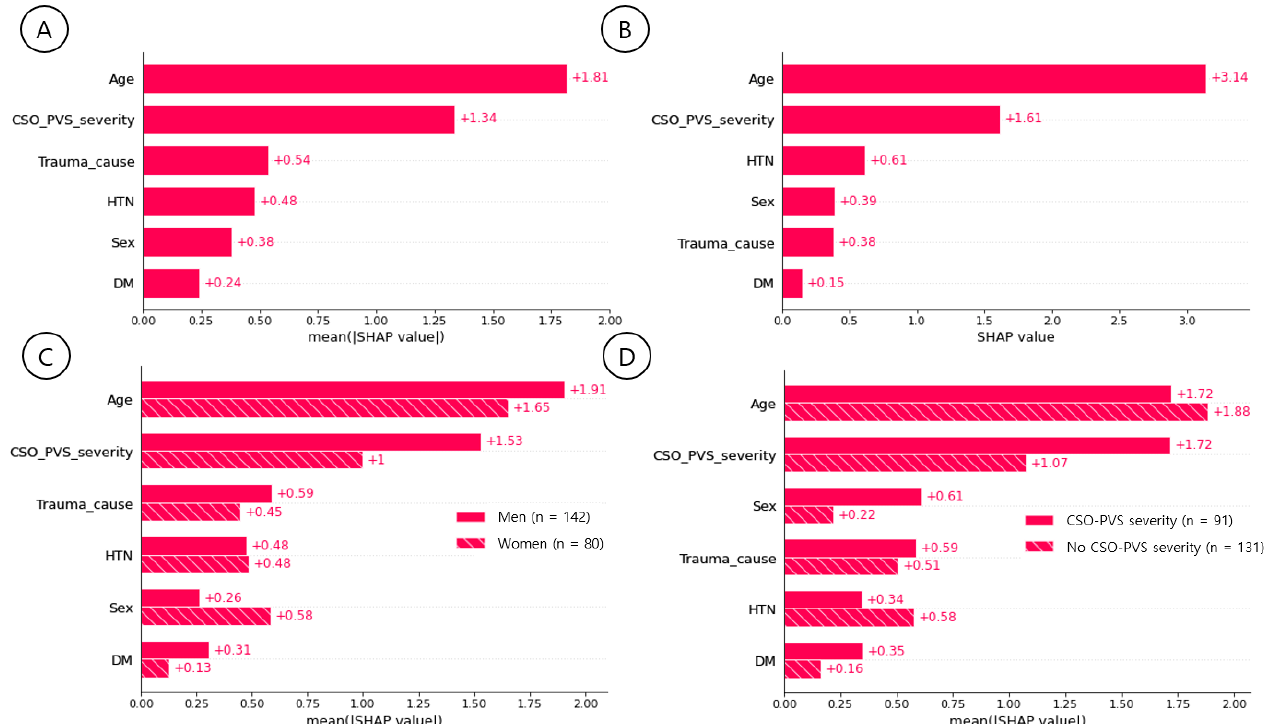
Figure 2. Feature importance analysis for the entire dataset and for each case: ( A ) overall feature importance indicates that age, CSO-PVS, trauma cause, and hypertension were important risk factors for de novo hygroma; ( B ) individual feature importance analysis for a 66-year-old man with hypertension, diabetes, and CSO-PVS due to a slipping-down accident indicates that age and CSO-PVS positively impacted the de novo hygroma status, and underlying disease and sex also positively impacted the de novo hygroma; ( C ) cohort feature importance for sex—the tendency is the same in all groups, except for sex; and ( D ) another cohort feature importance analysis for CSO-PVS. Age and CSO-PVS severity were strongly important risk factors. (HTN, hypertension; DM, diabetes).